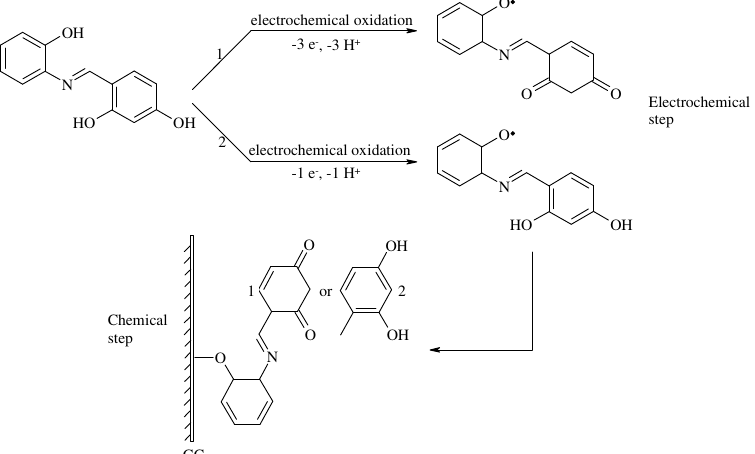
Figure 9 . Reaction mechanism for electrochemical oxidation and modification of HIBD on